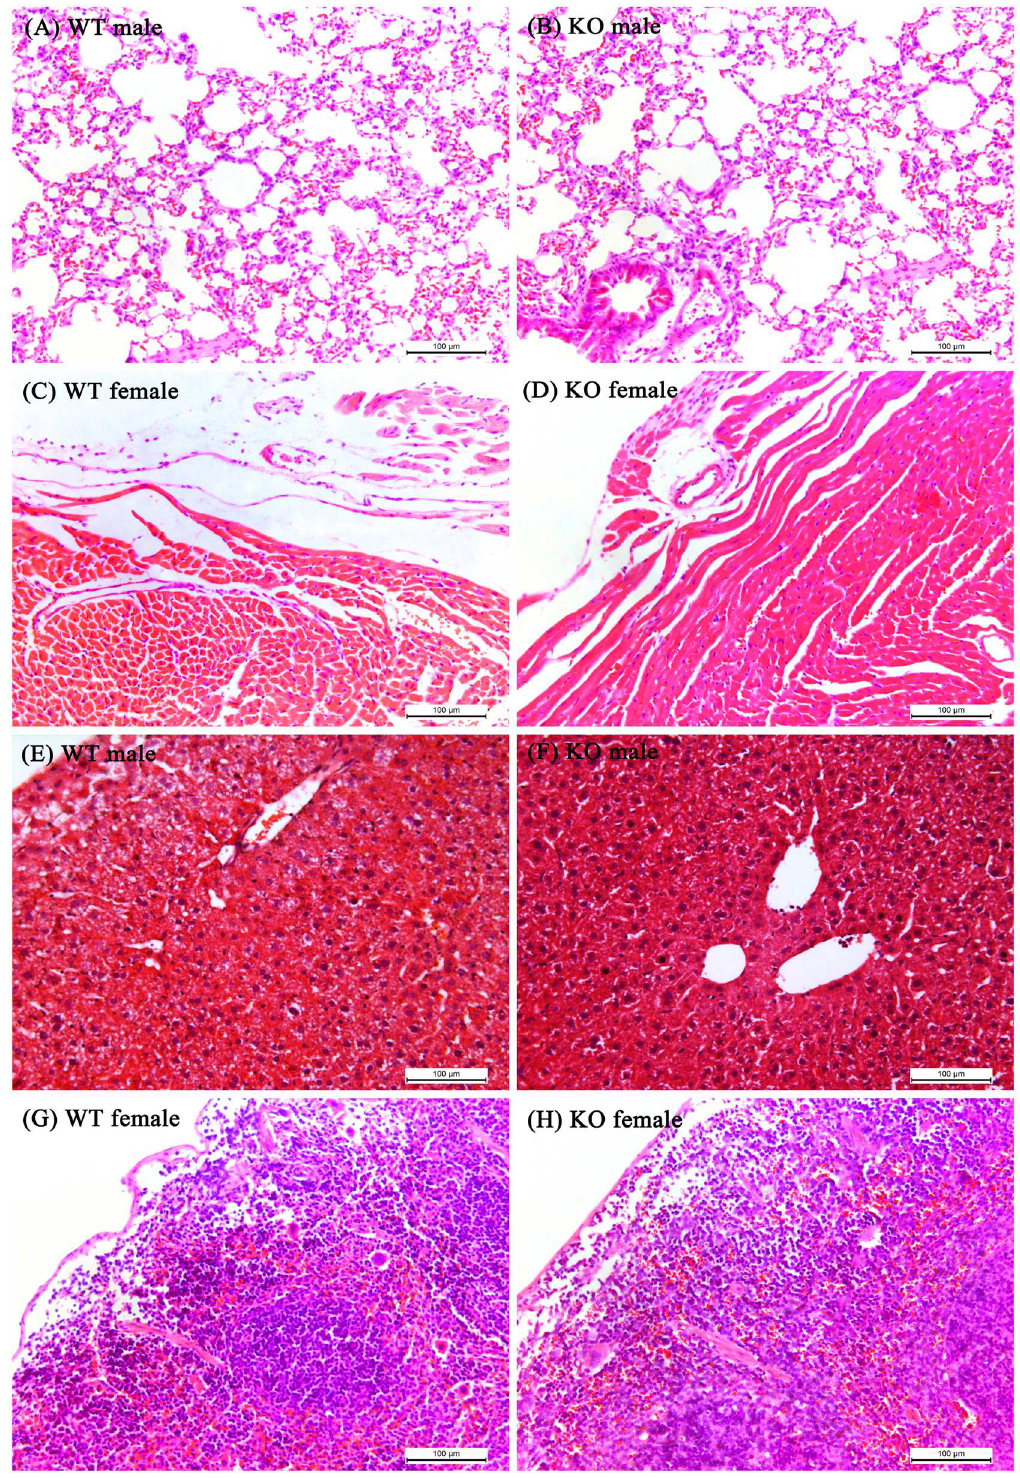
Fig 4. Representative photomicrographs of the vital organs. Sections fixed with paraformaldehydewere stained with haematoxylin and eosin (HE). Slides were observedwith a light microscope(200 × ),and representative photo- micrographsof sections of (A and B) lungs, (C and D) hearts, (E and F) livers, and (G and H) spleensfrom both the model and control groups are shown. No significantdifferenceswere observedfor any of the evaluationindices. (Mice were 8 weeks